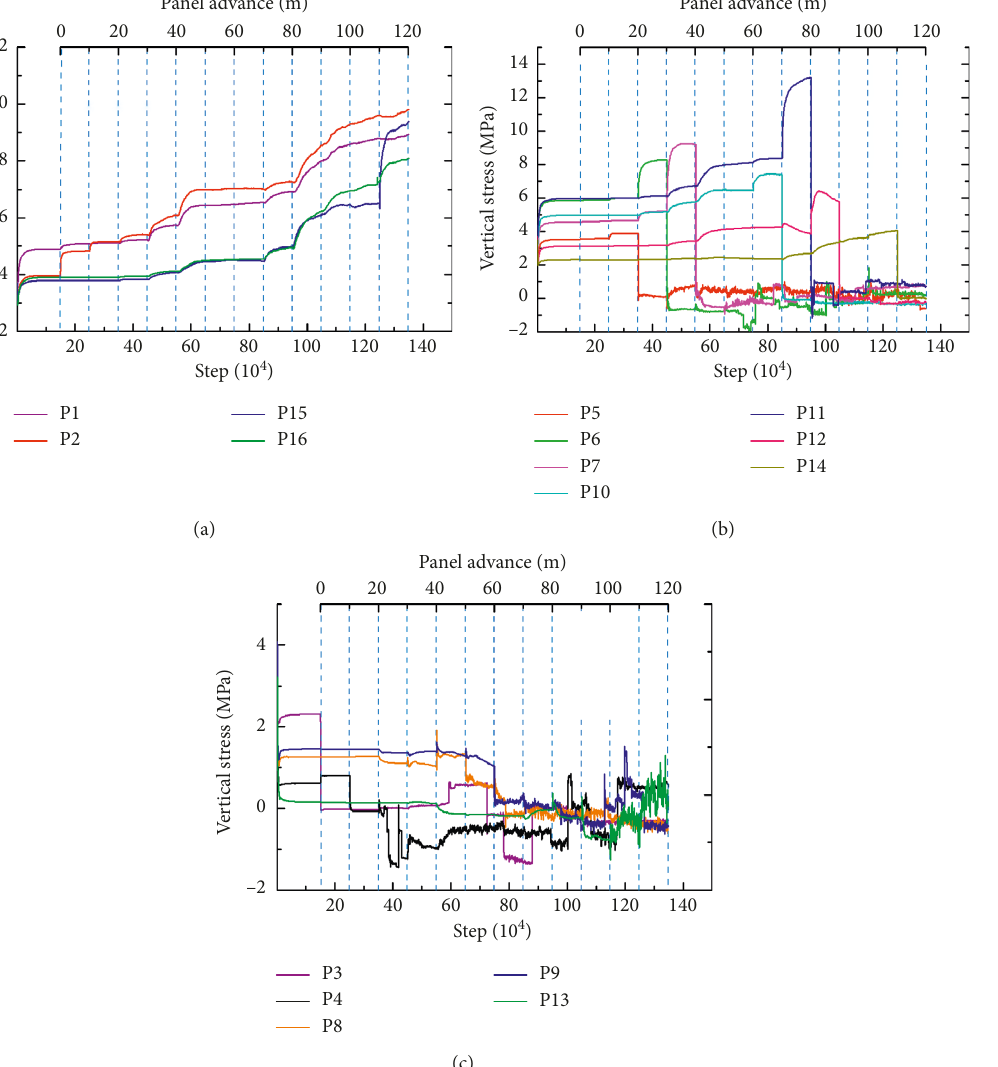
Figure 14: Evolution of vertical stress in the immediate roof of the #6 seam. (a) Under solid coal seam. (b) Under residual coal pillars. (c) Under mined-out When the advancing panel has not reached the measurement Figure 14(c) presents the evolution of the vertical stress point, the stress is slightly influenced by the front abutment recorded by the measurement points under mined-out area stress, and the maximum stress is only about 1.9MPa. After the (P3, P4, P8, P9, and P13). These measurement points record the panel has advanced past the measurement point, the stress stress within the stress relief zone. After the extraction of the #4 reduces to about zero and undergoes slight fluctuation. seam, the stresses are low, ranging from 0.2MPa to 2.2MPa.